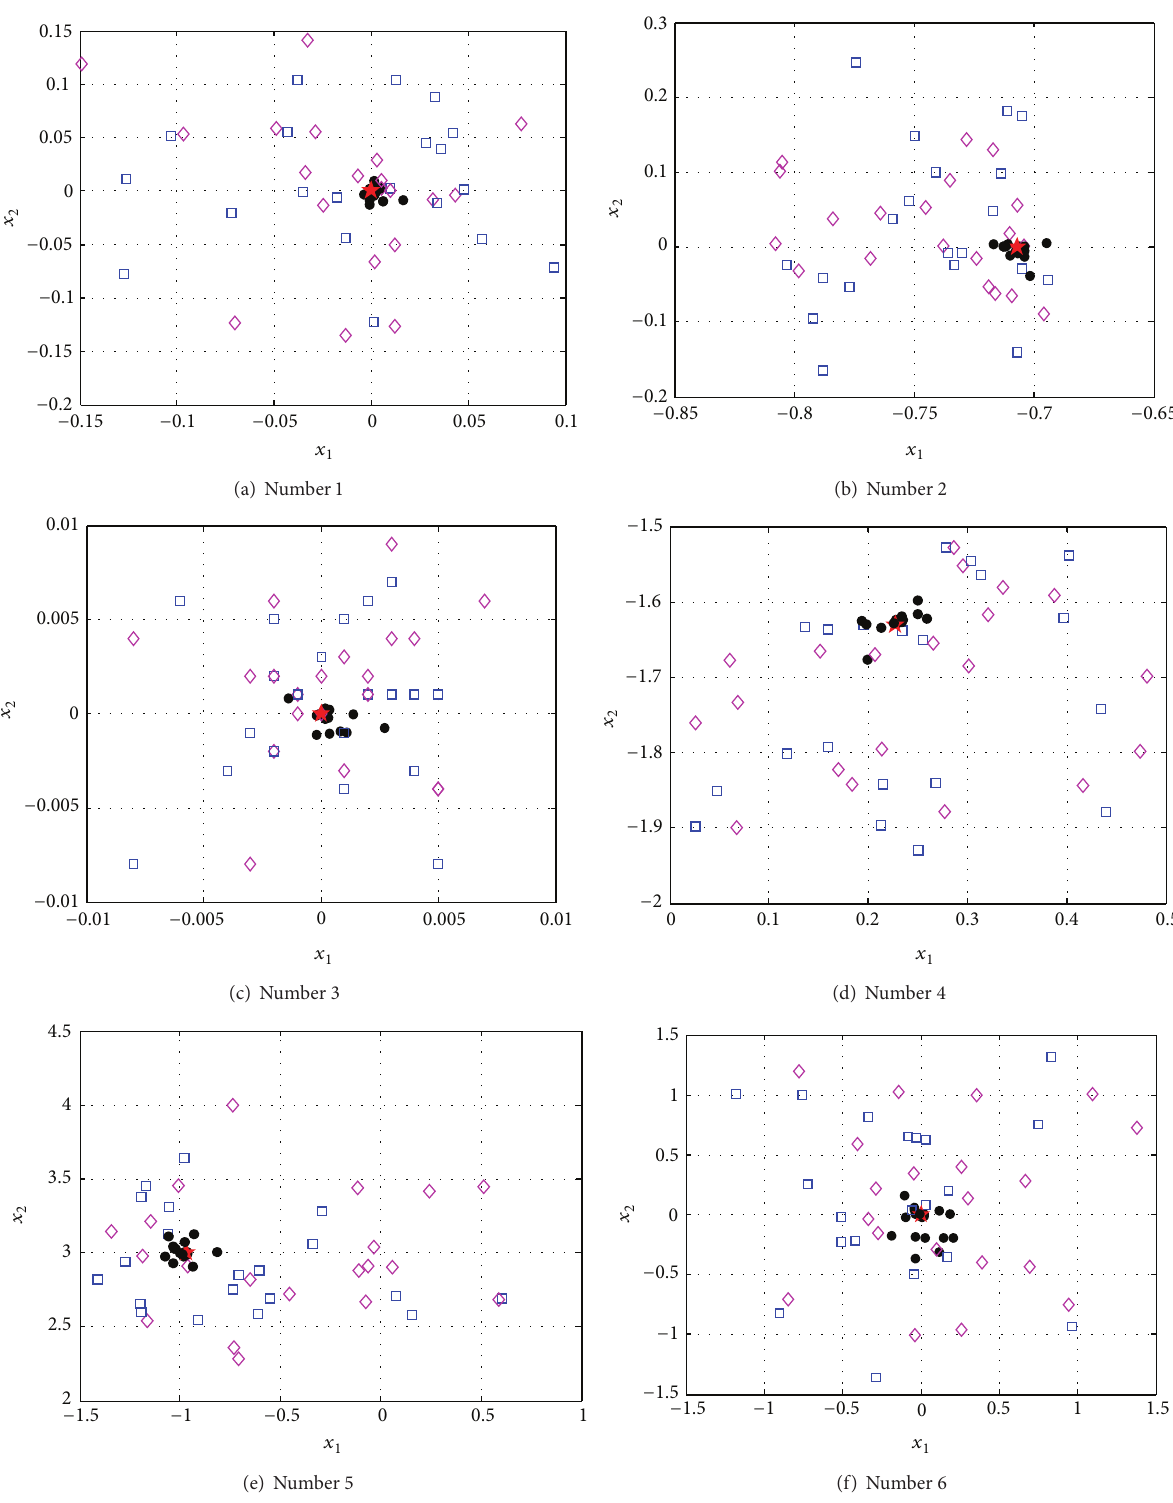
Figure 10: Global minima points of functions 1–6. (a)–(f) show the global minima points for functions 1–6 separately. The red pentagon indicates the actual global minimum point. The black dots indicate the global minima points of metamodels based on sampling method SOSM. The blue square indicates the global minima points of metamodels based on sampling method LHD. The magenta diamond indicates the actual global minima points of metamodels based on sampling method